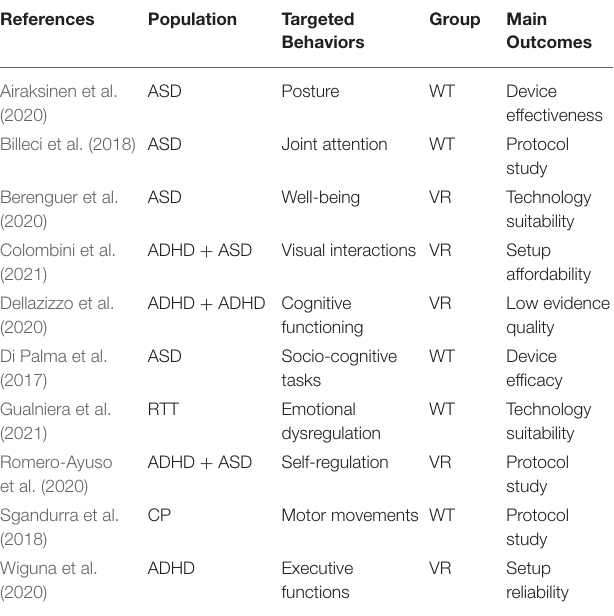
TABLE 1 | Reviewed studies arranged in alphabetic